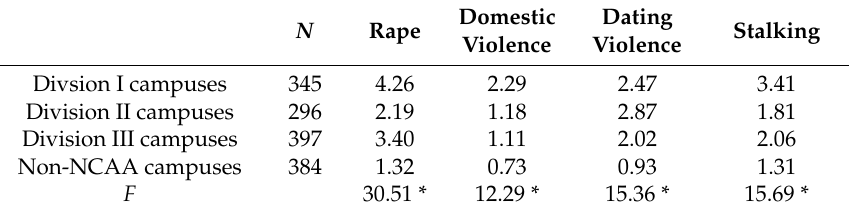
Table 1. Relationship violence across National Collegiate Athletic Association (NCAA) divisions.